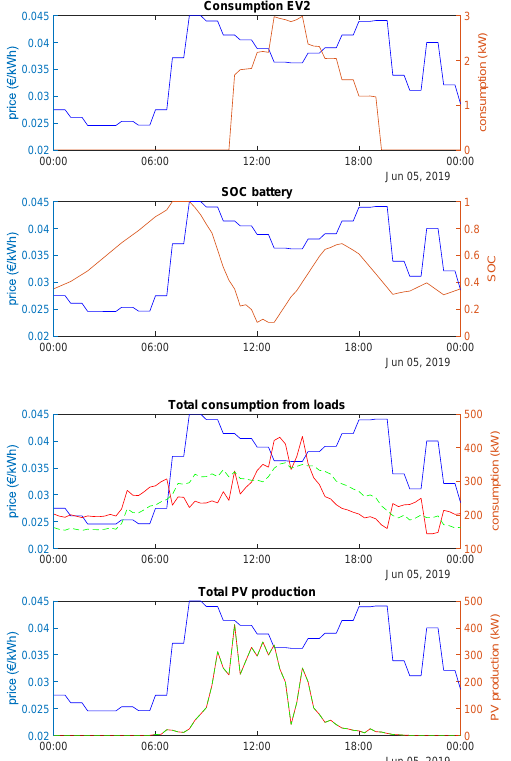
Figure 7. In red: power profiles scenario (b), for EV2, the battery, the aggregated loads and the total PV production (the green line shows the forecasted profile, and the red line the optimised one). In blue: electricity prices. Table 3. Costs or benefits in scenarios (a) and (b) Costs (>0) or benefits (<0)